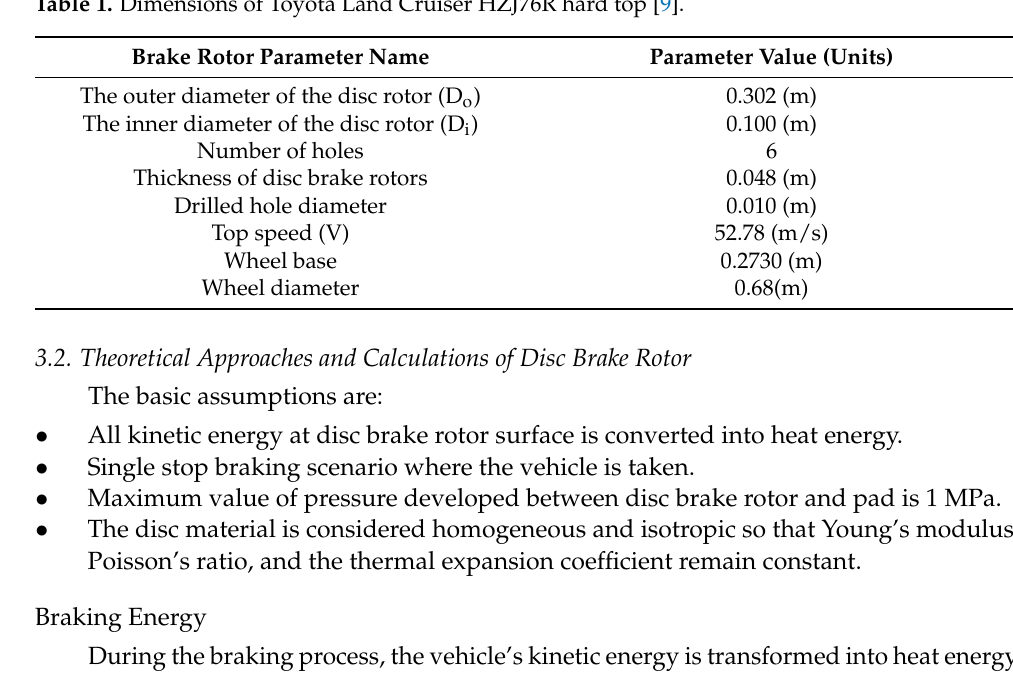
Figure 2. Three-dimensional representation of disc brake rotor. Table 1. Dimensions of Toyota Land Cruiser HZJ76R hard top [9].